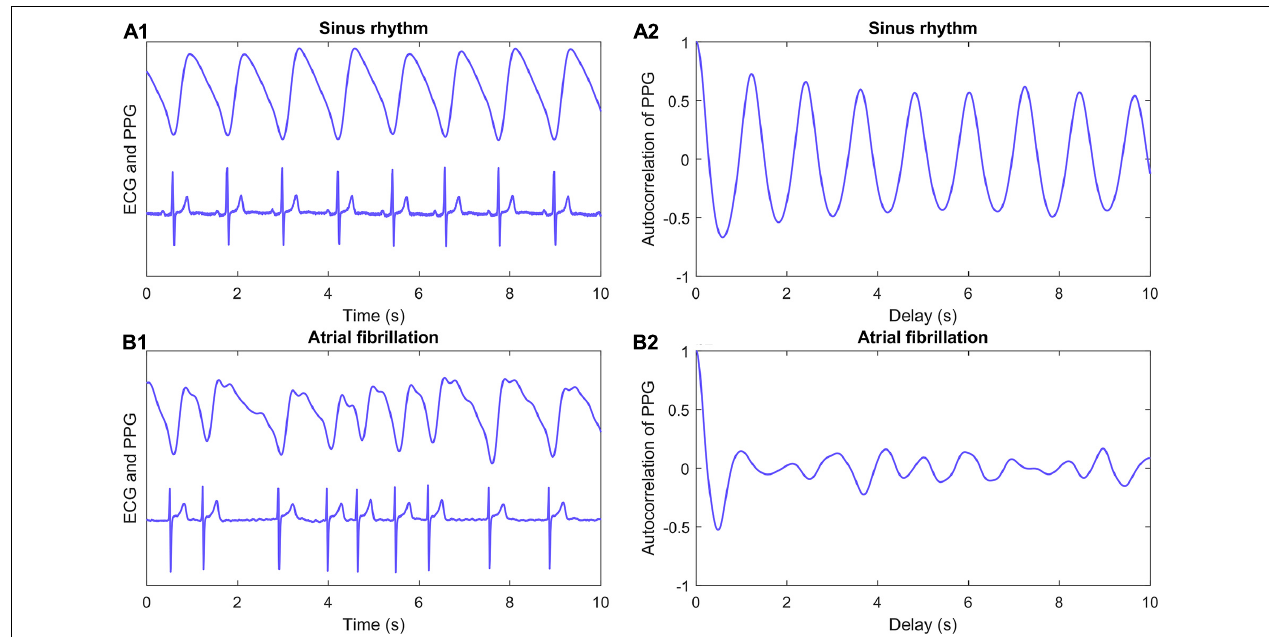
FIGURE 3 | Autocorrelation. PPG (upper) and ECG (lower) recordings from a patient with sinus rhythm (A1) and atrial fibrillation (B1) . Corresponding autocorrelation values were calculated for 1-min samples of PPG signal for each patient. First 10 s of example recordings and calculated autocorrelation values (A2 and B2) are shown in panels. Autocorrelation is a feature calculated straight from the signal and it requires no pulse detection. It is the correlation between a signal and its delayed copy as a function of delay. ECG, electrocardiogram; PPG,